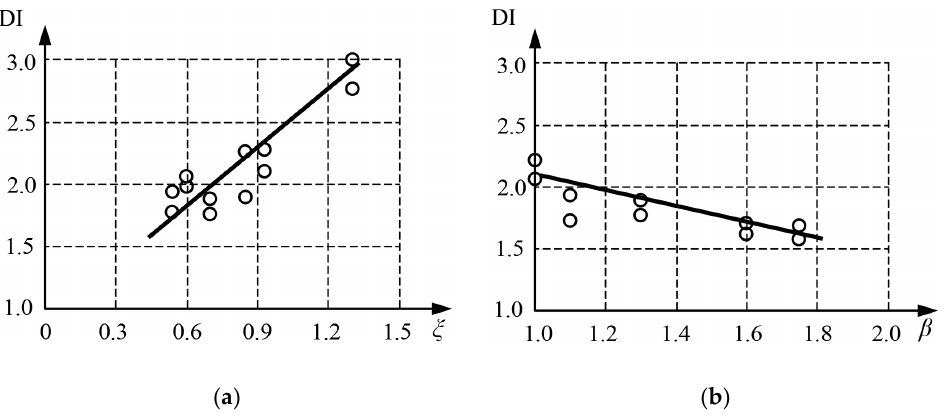
Figure 4. Ductility index DI versus: ( a ) steel contribution ratio ξ with β = 1.3; ( b ) the ratio of the cross-sectional dimensions β, with ξ = 0.7 , based on [38].